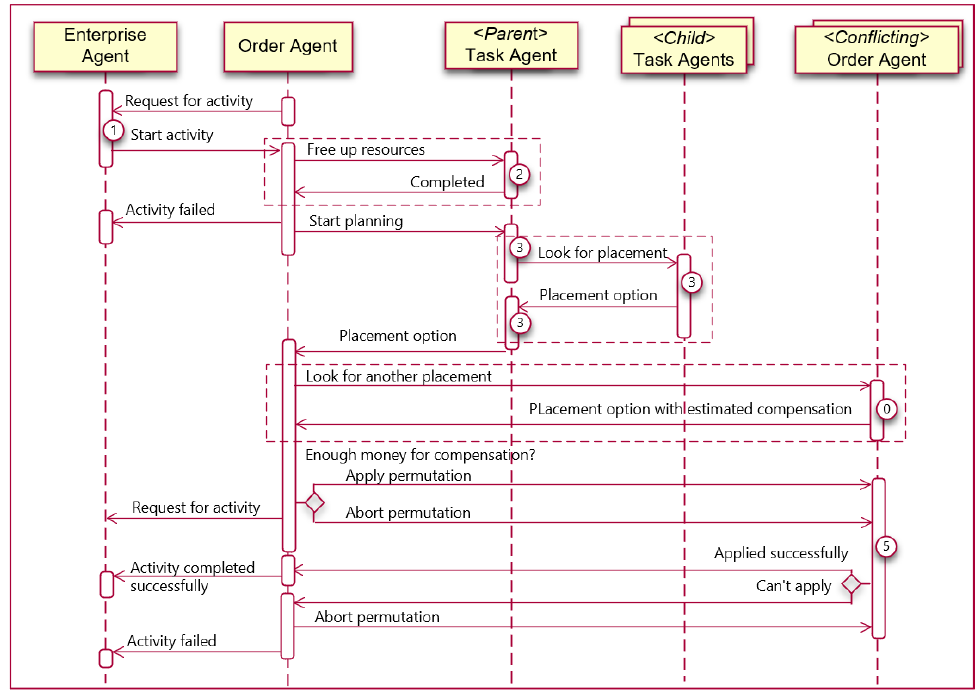
Figure 3. The modified protocol of agent interaction and coordinated decision making for solving conflicts and reaching consensus.